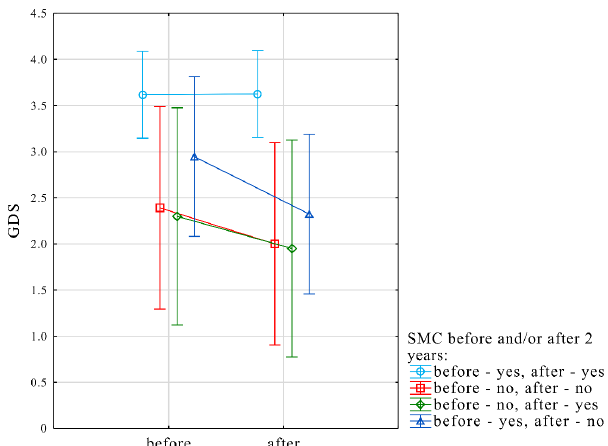
Figure 4. Results of linear mixed model predicting GDS score change over two years in relation to the presence of subjective and objective verbal memory decline. Y-axis represents the score on the Geriatric Depression Scale (GDS). X-axis (“before” and “after”) denotes the initial time-point and after two years, respectively. Light blue line indicates the subgroup of subjective memory complaint (SMC) at both time-points, red line indicates subgroup without SMC at both time-points. Green line indicates participants who were free of SMC at the initial time-point, but it changed after two years (after). Dark blue line denotes subgroup with SMC at the initial time-point and who was free of SMC after two years (after).